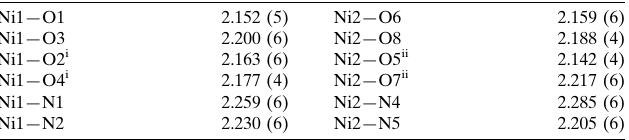
Selected bond lengths (A˚ ).